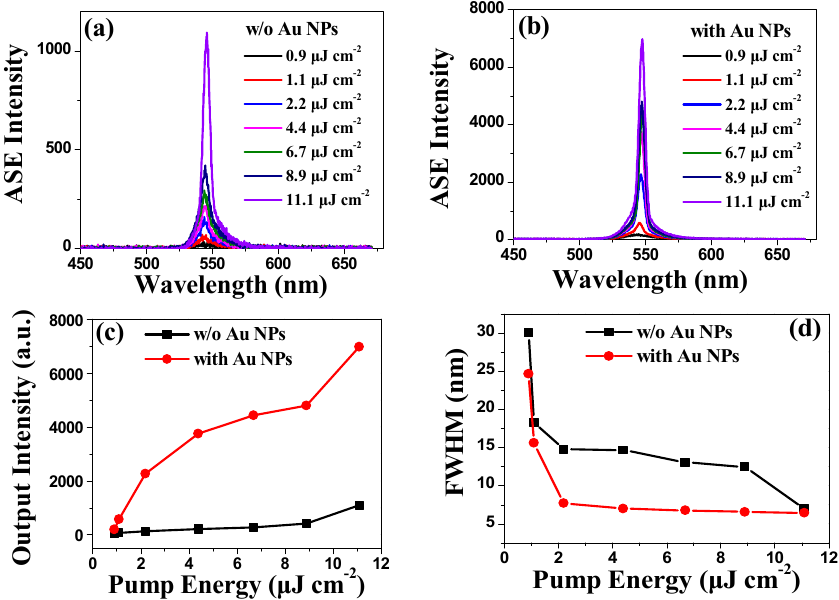
Figure 4. The emission spectrum Device Quartz/PEDOT: PSS/MAPbBr 3 ( a ) w/o Au NPs, ( b ) with Au NPs. The ASE peak intensity and FWHM of the emission spectra as a function of the pump energy ( c ) w/o Au NPs, ( d ) with Au NPs.